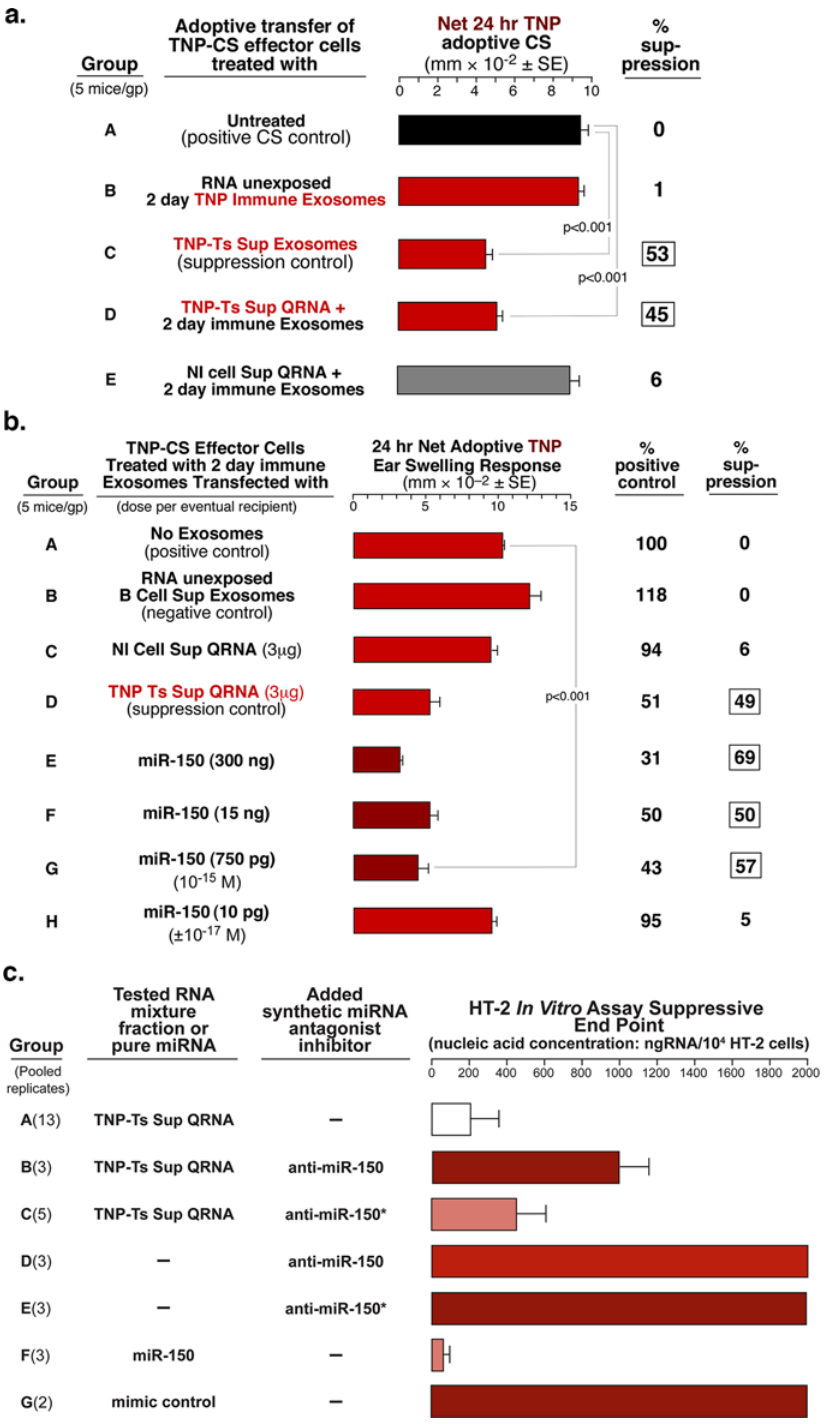
Fig 6. Suppression by extracellular QRNA from TNP Ts Sup free of exosomes, or miR-150 alone, associating with B-cell derived Ag-specific exosomes from the assayed CS-effector cell mixture. a. Treatment of TNP-CS-effector cells with two day immune B-1 B cell-derived TNP-specific exosomes that are supplemented with QRNA from TNP Ts Sup (Group D) results in significant suppression of the adoptive transfer. b. Similarly, two day immune B-1 B cell-derived exosomes, supplemented with decreasing doses of miR-150 alone, mediated suppression of TNP-CS-effector cell adoptive transfer (Groups E-G), down to